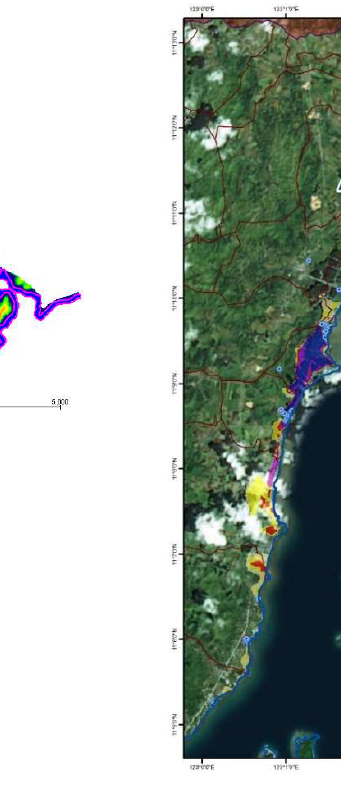
Figure 13. Effect of coastal shape on flow depth and extent in areas with the same elevation (Ajuy, Iloilo). The right panel shows inland inundation, whereas the left panel shows elevation contour (pink line is flooding extent), proving that inundated regions are low-lying coasts.